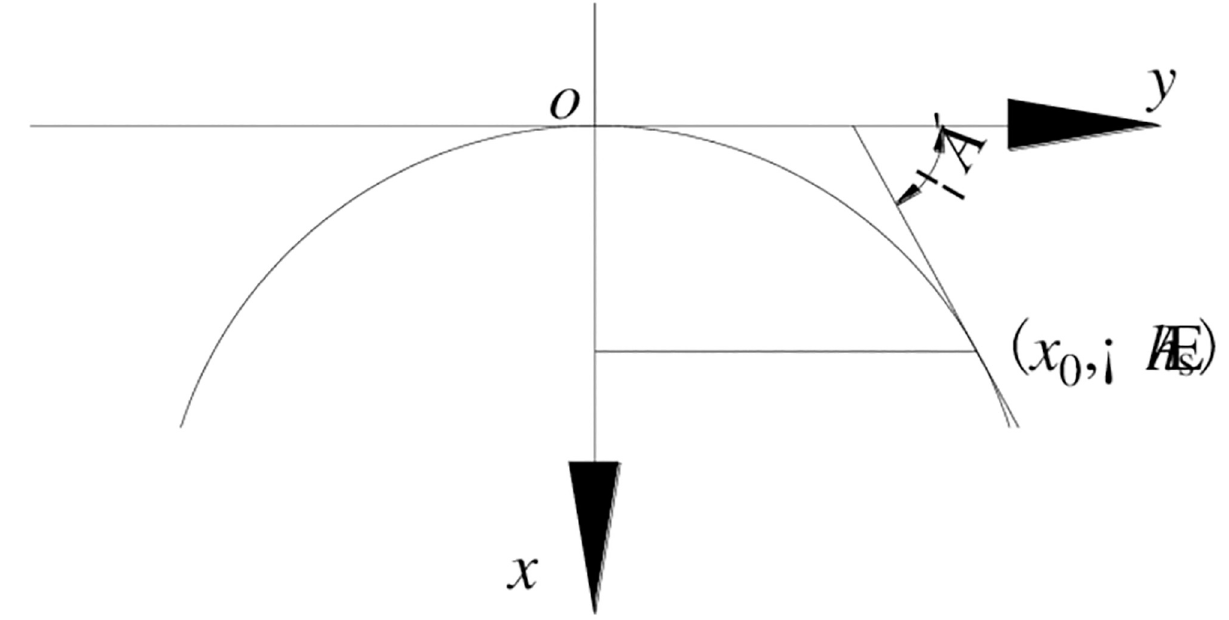
Fig 4. Simplified diagram of the given load of loose